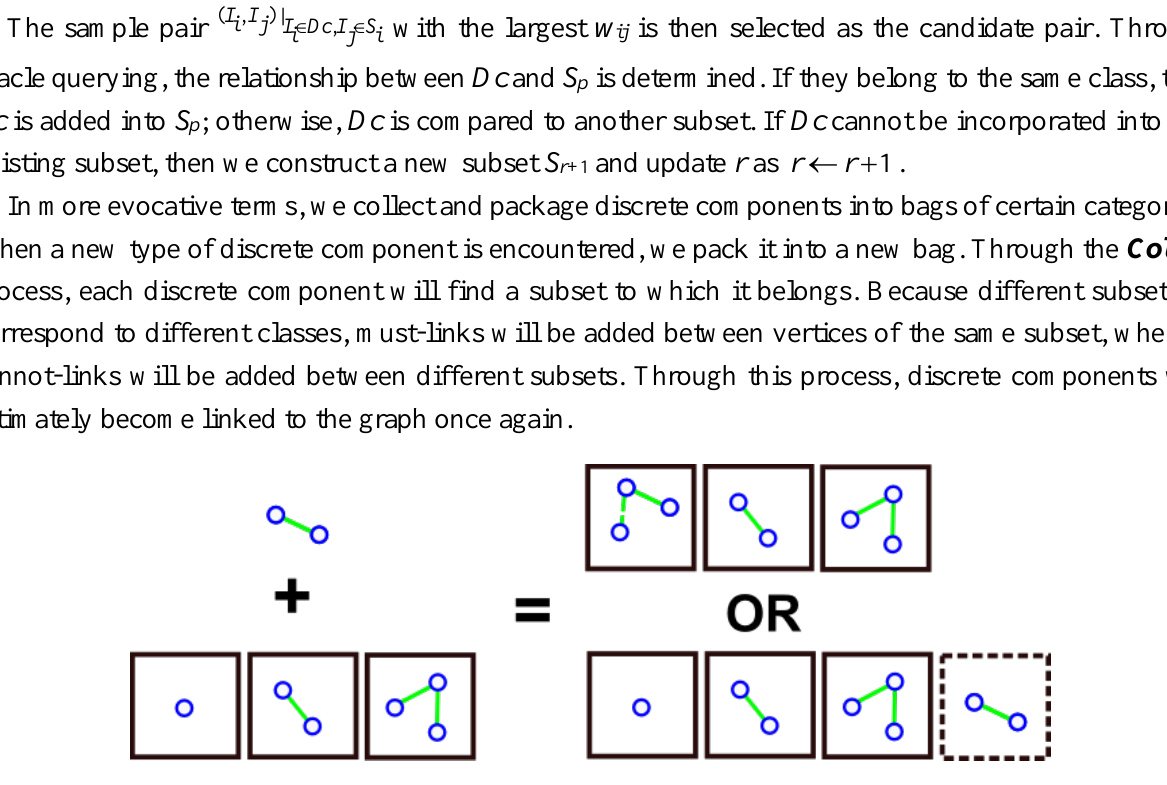
Figure 6. Collect process: Add a new discrete component to a subset of S or construct a new subset if